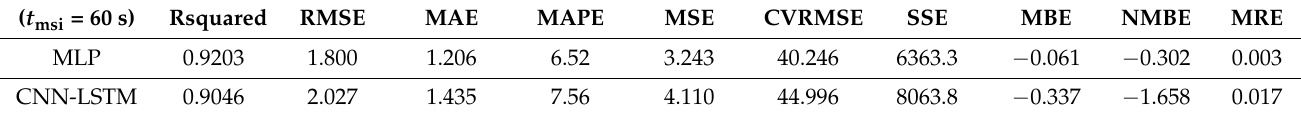
Table 4. Error metrics comparison for typical models.